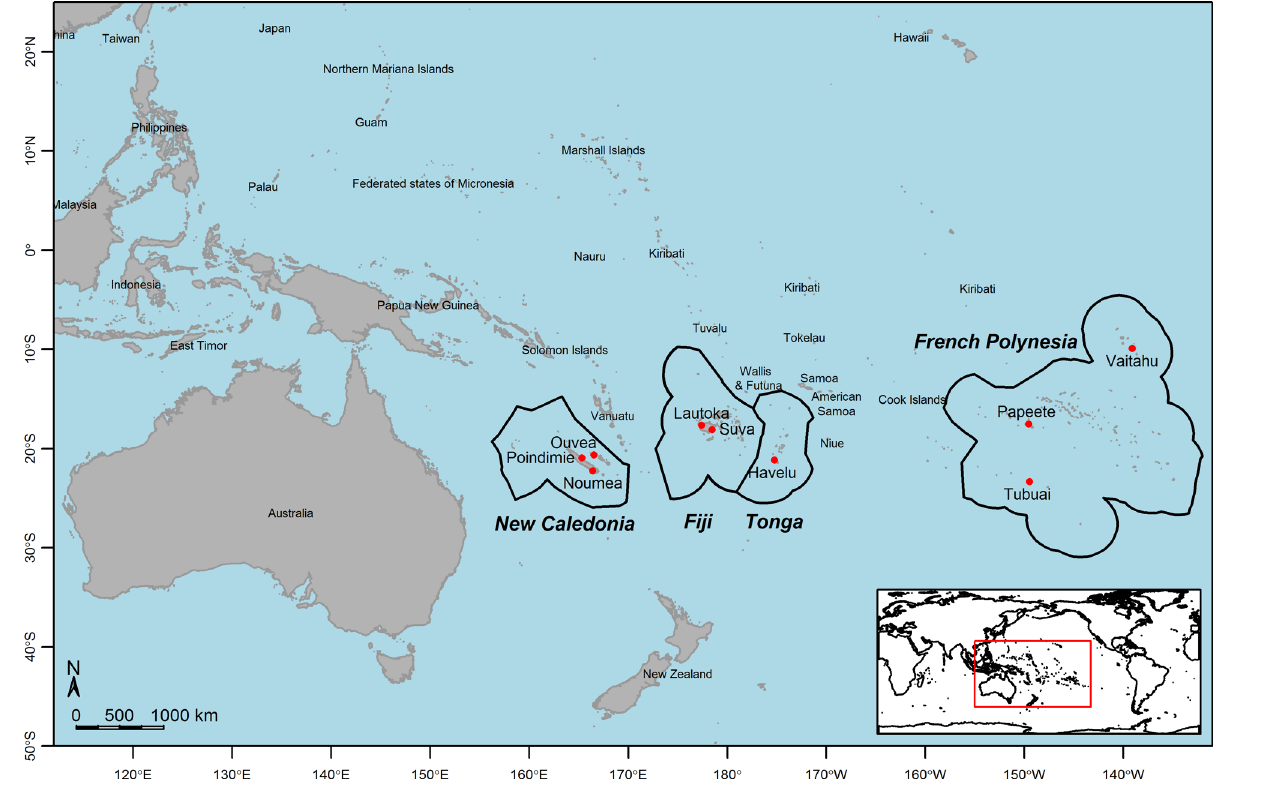
Fig 1. Pacific map locating Ae . aegypti sampling sites, 2013. The nine sample sites are represented by the red dots.